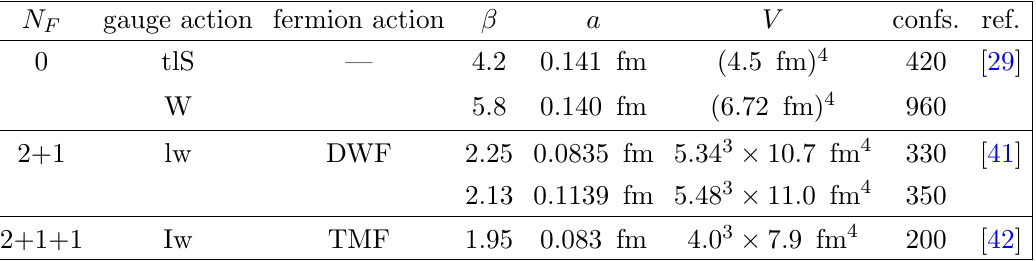
Table 1 . Set-ups for the di(cid:11)erent ensembles of lattice data that have been exploited for this paper. Concerning the codes for the actions, tlS stands for tree-level Symanzik, W for Wilson, Iw for Iwasaki, DWF for Domain-Wall fermions and TMF for twisted-mass fermions. while the Green’s function method will be applied for all of the lattice ensembles